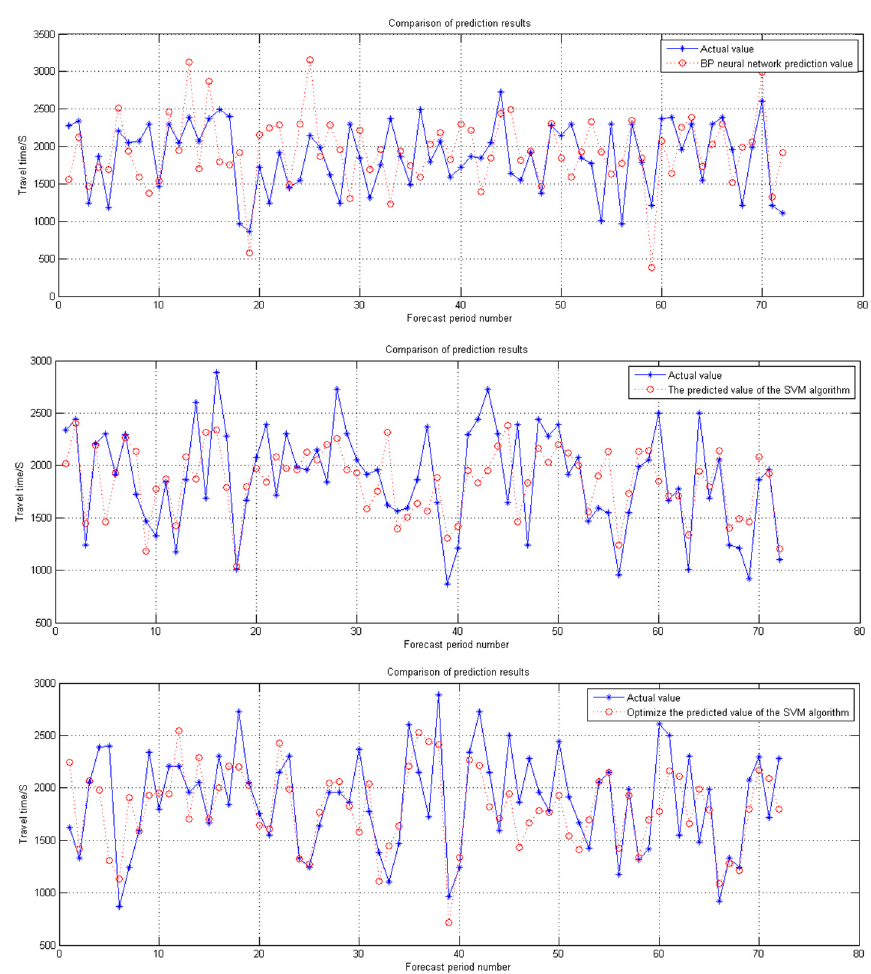
Figure 5. Results of freeway travel time prediction.